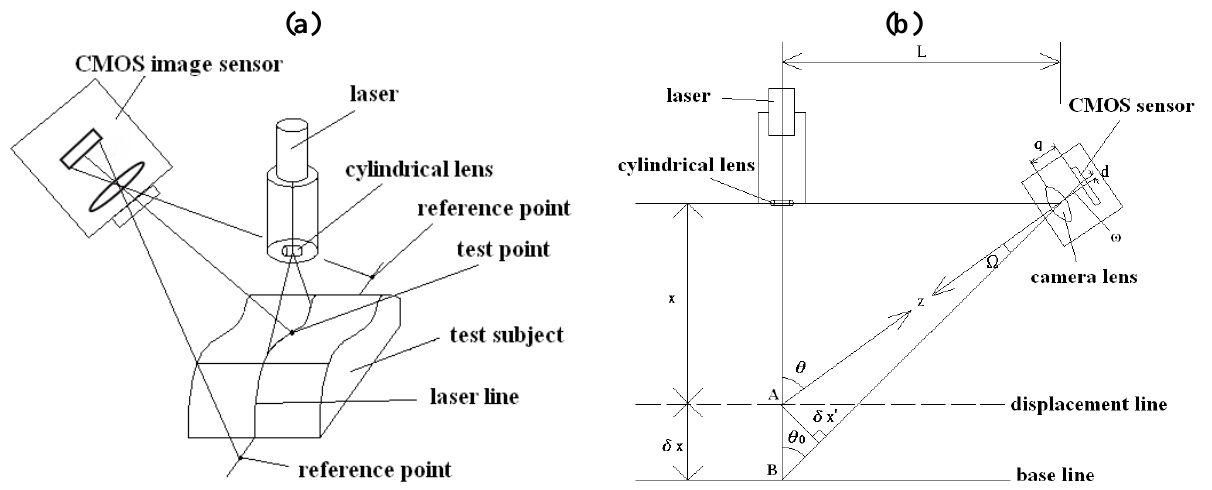
Figure 1. Geometrical layout of the Parkinson’s disease patient arm vibration measurement system [13]. (a) The system 3D layout. (b) The system 2D